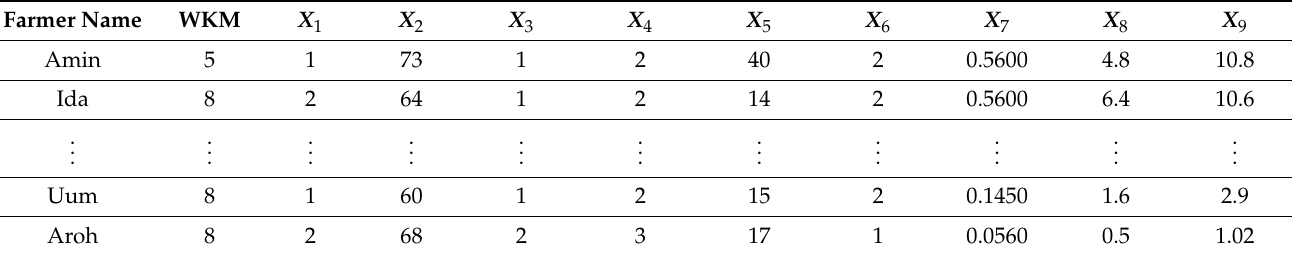
Table 1. Data relating to rice farmers in Cibungur